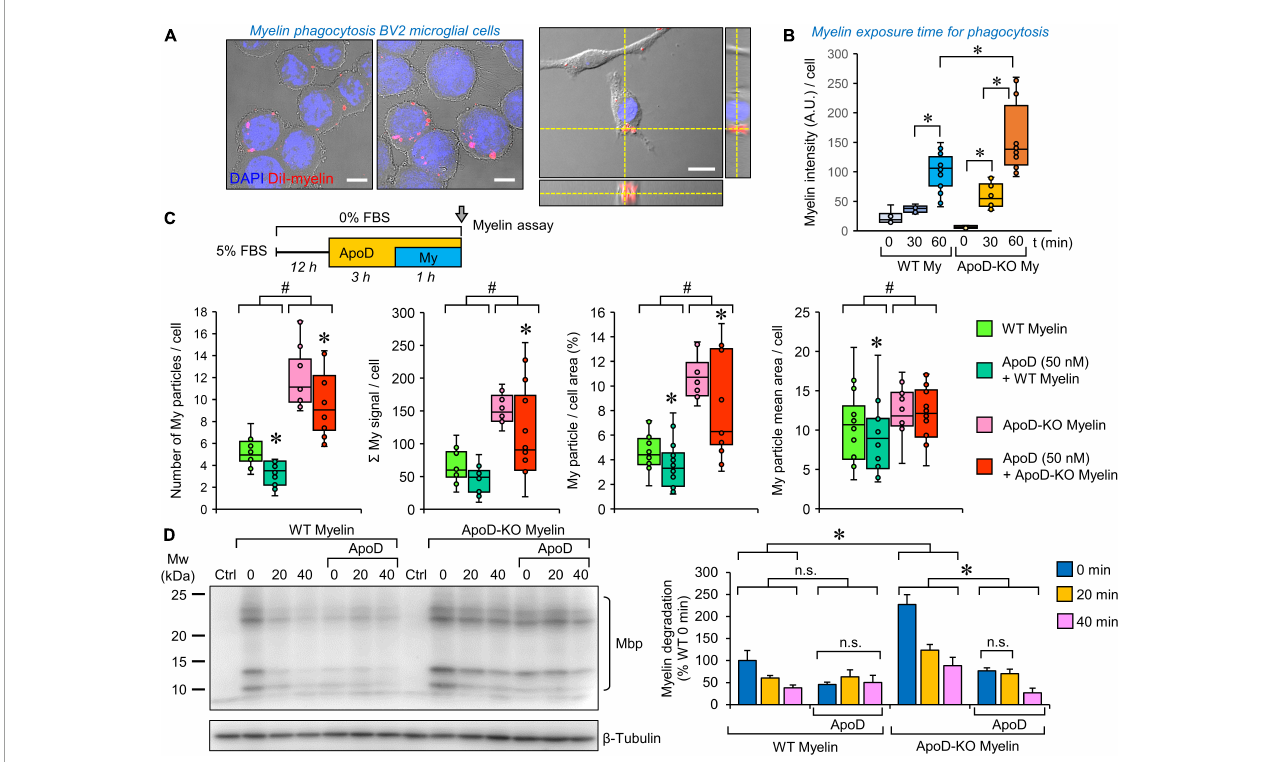
FIGURE5 Microglial myelin phagocytosis and degradation depends both on myelin ApoD genotype and exogenous ApoD addition. (A) Representative images of differential interference contrast (DIC), DAPI and DiI fluorescence showing that BV2 microglial cells are able to phagocytose DiI-labeled myelin. The right panel shows an orthogonal view derived from a Z-stack to demonstrate the internalized DiI-labeled particles. (B) Temporal pattern of DiI-labeled particle incorporation into BV2 cells exposed to WT or ApoD-KO myelin extracts. Total DiI intensity/number of cells is measured ( N = 3 independent experiments, 6–16 pictures/time point/genotype). Based on these experiments we selected a 60 min incubation time for further analysis. (C) Myelin genotype affects the number of phagocytosed myelin particles, their total intensity, the percent area occupied by myelin within the cell, and the mean particle area after 60 min exposure of BV2 microglia to DiI-labeled myelin. A total 398–413 individual cells were measured ( N = 3 independent experiments, 4 pictures/experimental condition). Each dot in box plots represents the average value/picture. ApoD-KO myelin shows increased values in the four variables analyzed. The addition of exogenous ApoD (50 nM) 3 h before exposure to myelin reduces these values in an ApoD genotype-dependent manner. (D) Myelin degradation was assayed by immunoblot against Mbp normalized to β -tubulin ( N = 3 independent experiments). Four major bands specifically detected by the anti-Mbp antibody were quantified and added to measure the time-course of MBP degradation. Pre-treatment of BV2 cells with exogenous ApoD slows down myelin degradation independently of myelin ApoD genotype. Statistically significant differences were evaluated with ANOVA (two-way in panels B,C ; three-way in panel D ) followed by Holm-Sidak pairwise comparisons. # indicate differences due to myelin ApoD genotype ( p < 0.001). Asterisks indicate differences due to ApoD pre-exposure within each myelin type ( p < 0.05). Calibration bars: 10 µ m ( A , left panels); 20 µ m ( A , right